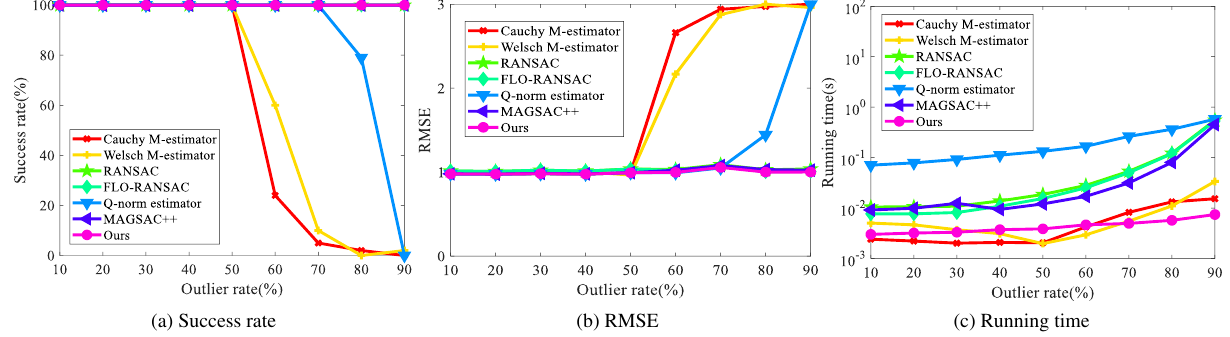
Figure 4. Comparison of line fitting results on the simulated data.